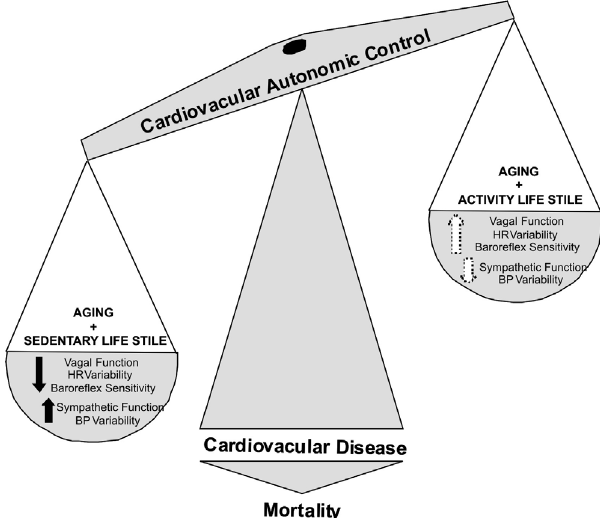
Figure 3 - A schematic representation of age-related alterations to the autonomic nervous system, and of the role of chronic exercise in reducing or preventing these alterations. Aging combined with a sedentary lifestyle is associated with changes in the autonomic nervous system’s control of the cardiovascular system. Autonomic changes involve decreases in vagal function, HR variability and baroreflex sensitivity, as well as increased sympathetic function and BP variability. These changes are associated with high rates of cardiovascular disease and mortality. Chronic exercise prevents these autonomic changes and reduces the rates of cardiovascular disease and mortality as they relate to